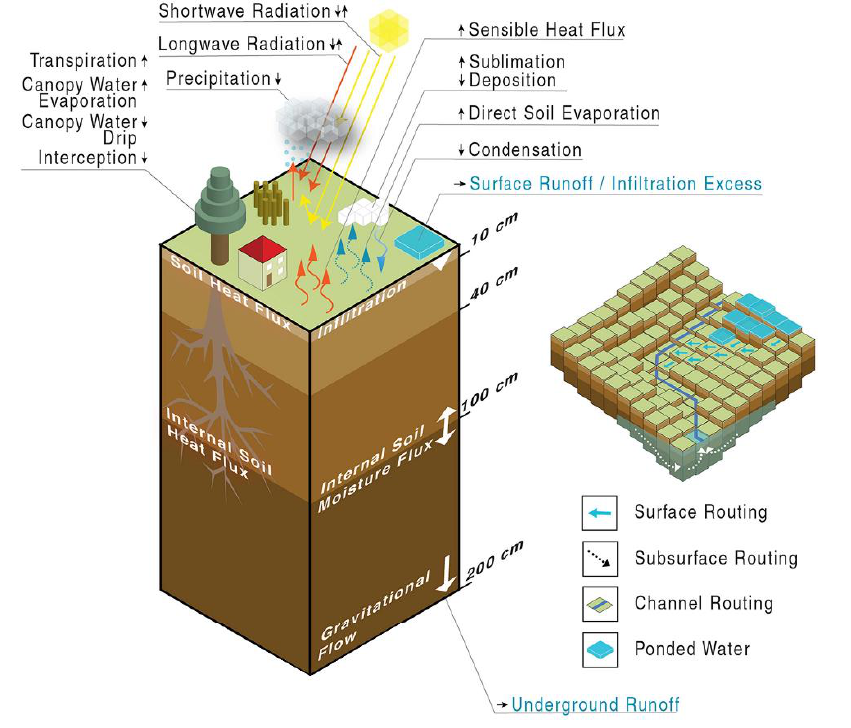
Figure 3. The WRF–Hydro modeling architecture coupling Noah–MP land surface processes with hydrological routing (adapted from [28]). Adapted with permission from Ref. [28]. 2019 Thomas Rummler